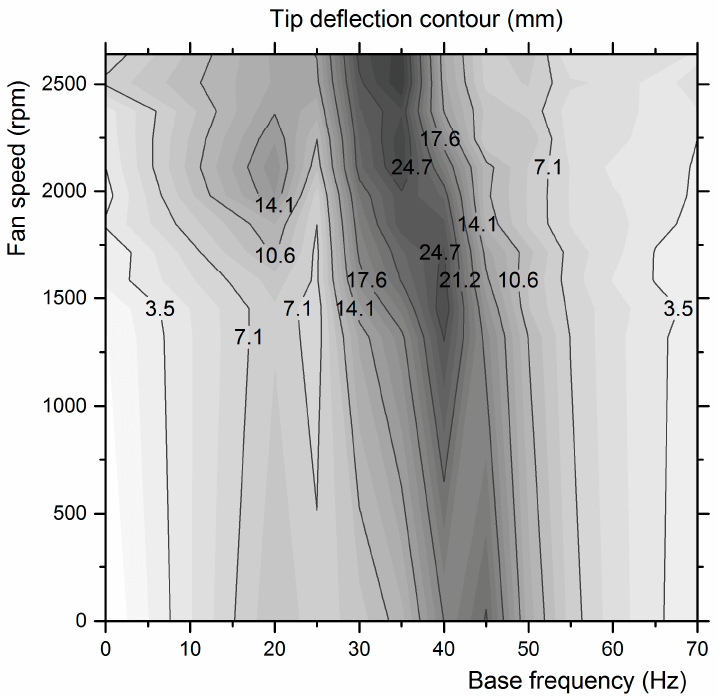
Figure 14. Laser projection of the 4 points with maximum harvested power.